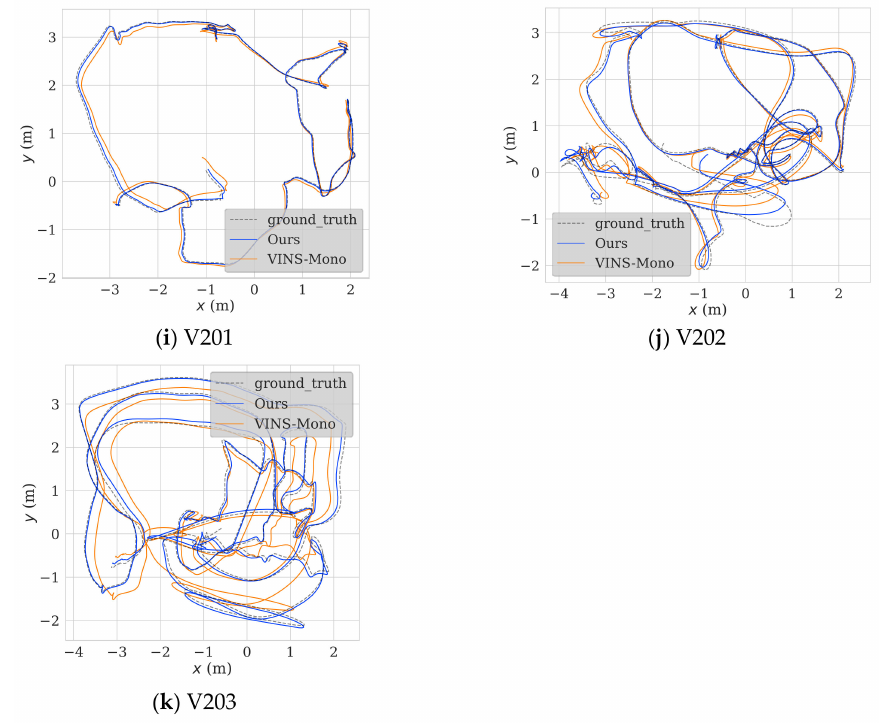
Figure 9. Trajectories computed by the proposed algorithm and VINS-Mono. The absolute pose precision of the proposed algorithm was evaluated using its root- mean-square absolute pose error (RMS-APE) for the EuRoc dataset, as shown in Figure 10. Although large fluctuations occurred in some spots, the RMS-APE only ranged from 0.074 to 0.31 over all of the EuRoc sub-datasets. Furthermore, the localization precision of the algorithm was better than 30 cm across all of the sub-datasets.